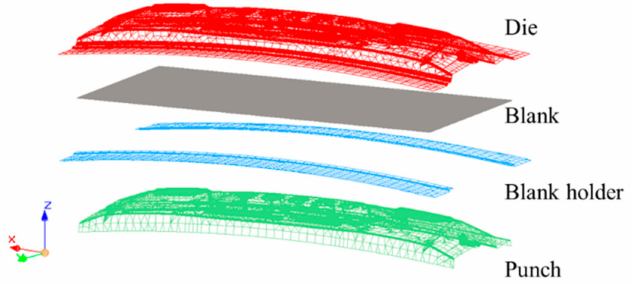
Figure 13. Finite element model for the drawing process of the automobile component.